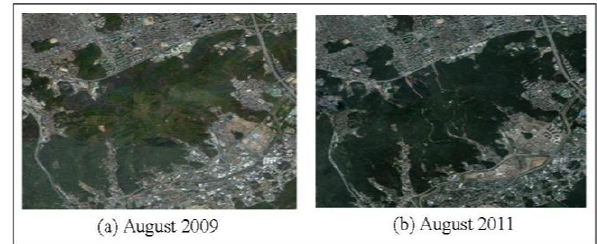
Figure 4. Aerial images before and after the debris flow damage